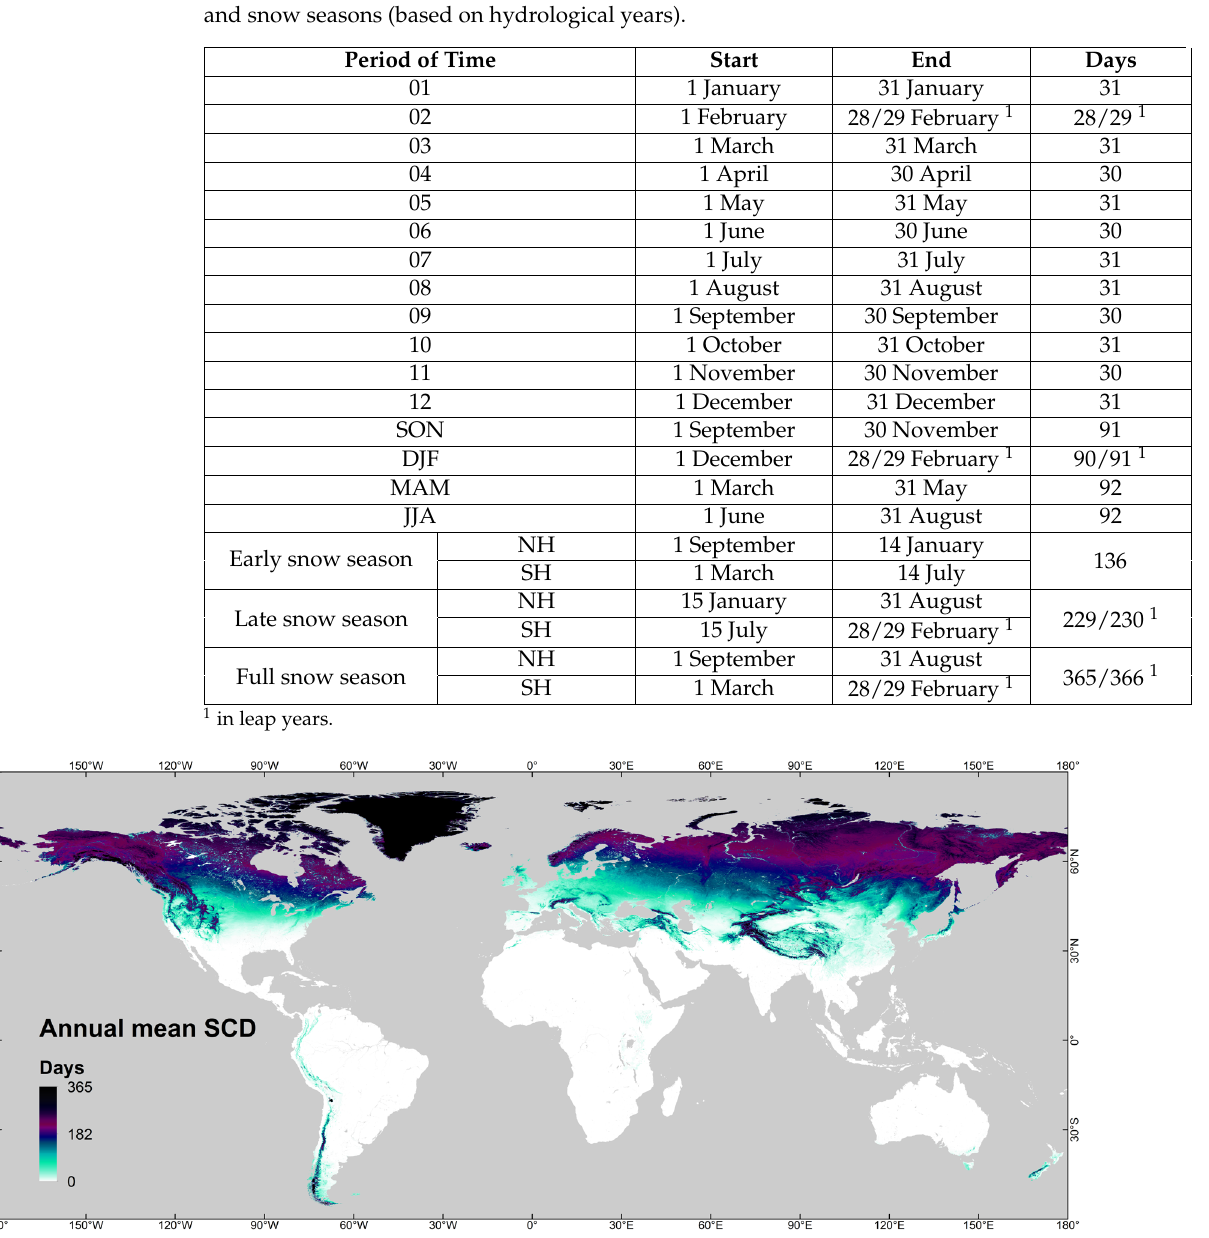
Figure 2. Annual mean snow cover duration ( SCD full ) derived from 23 hydrological years